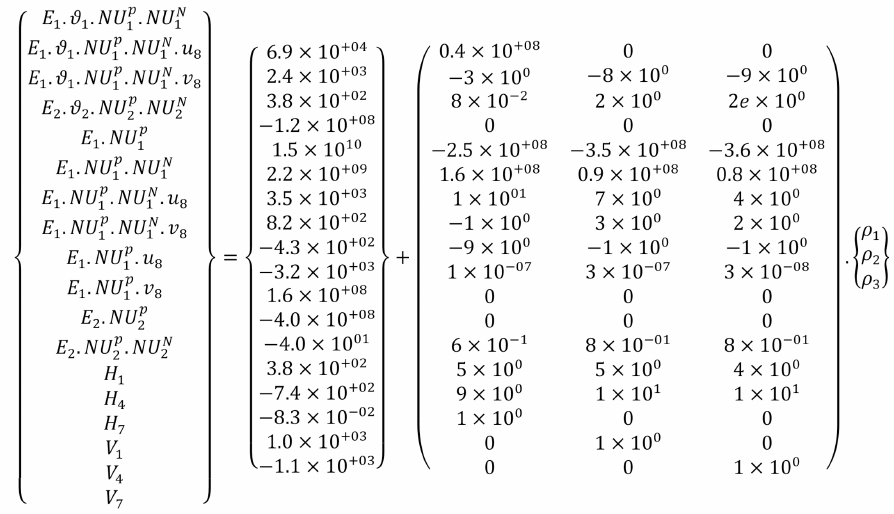
Figure 3. General solution of the system of